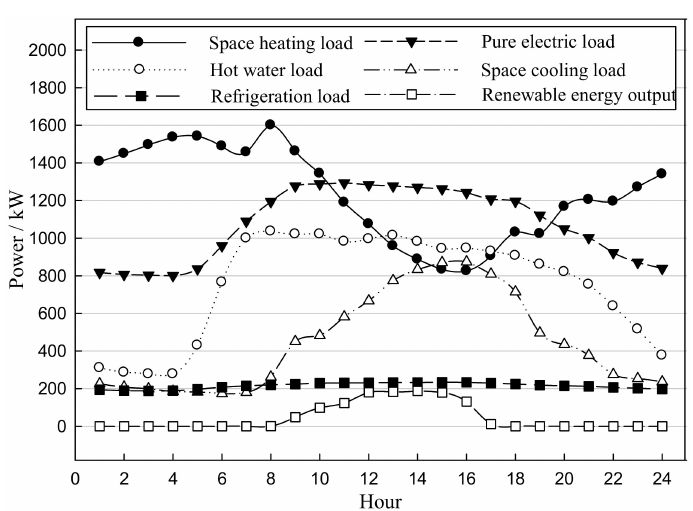
Figure 7. The day-ahead forecasting curves of the cooling, heating and electrical load and renewable energy power output in the integrated energy system.